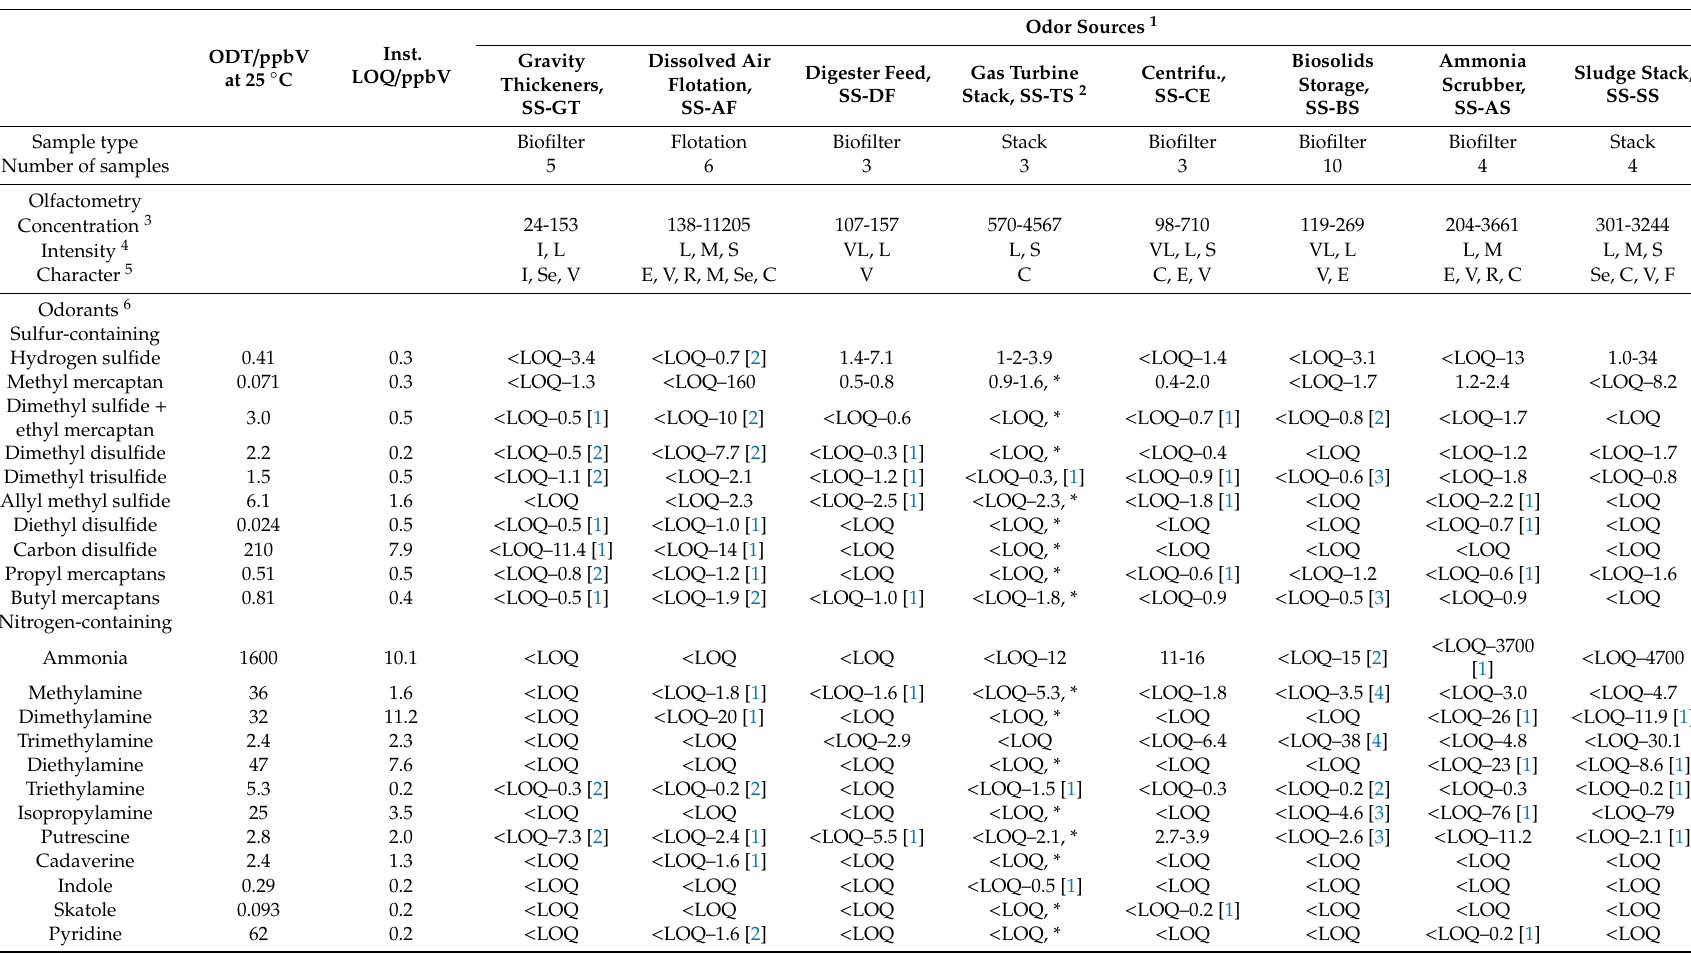
Table 7. Sensory data and SIFT-MS concentration data (in ppbV) for odor sources from secondary solids treatment. The range of values for each source is shown. See the text and table footnotes for more